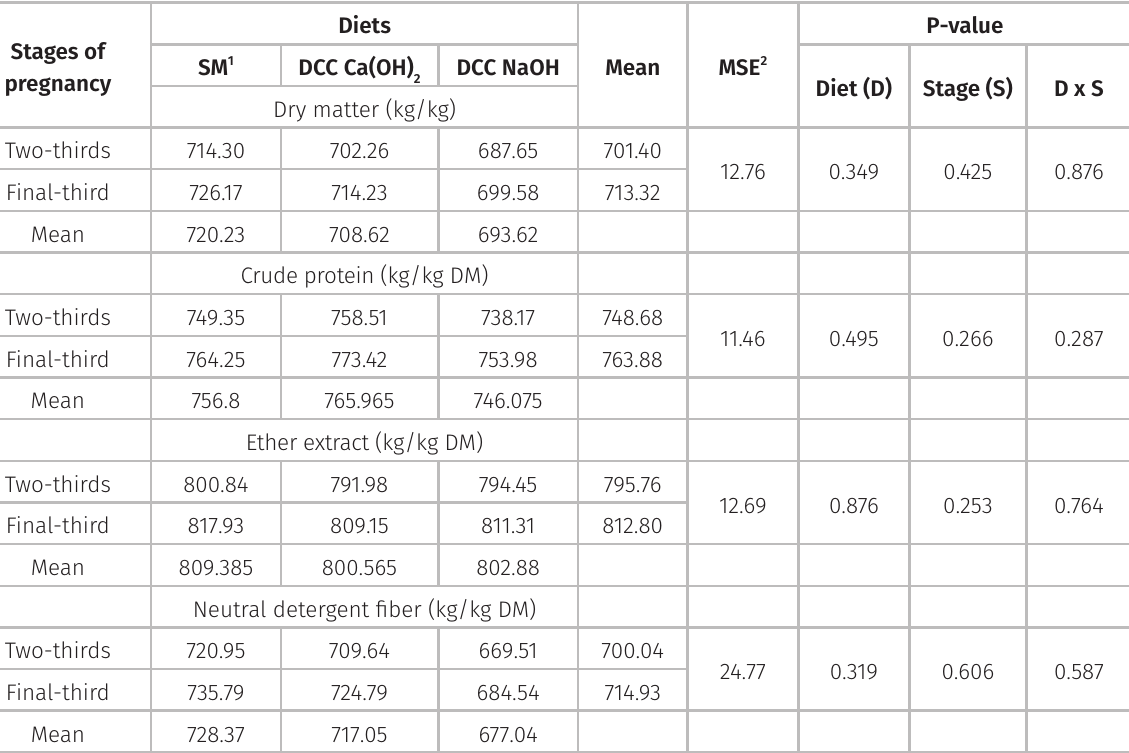
Table V. Digestibility of dry matter and nutrients of goats fed with detoxified castor cake (DCC) at different stages of